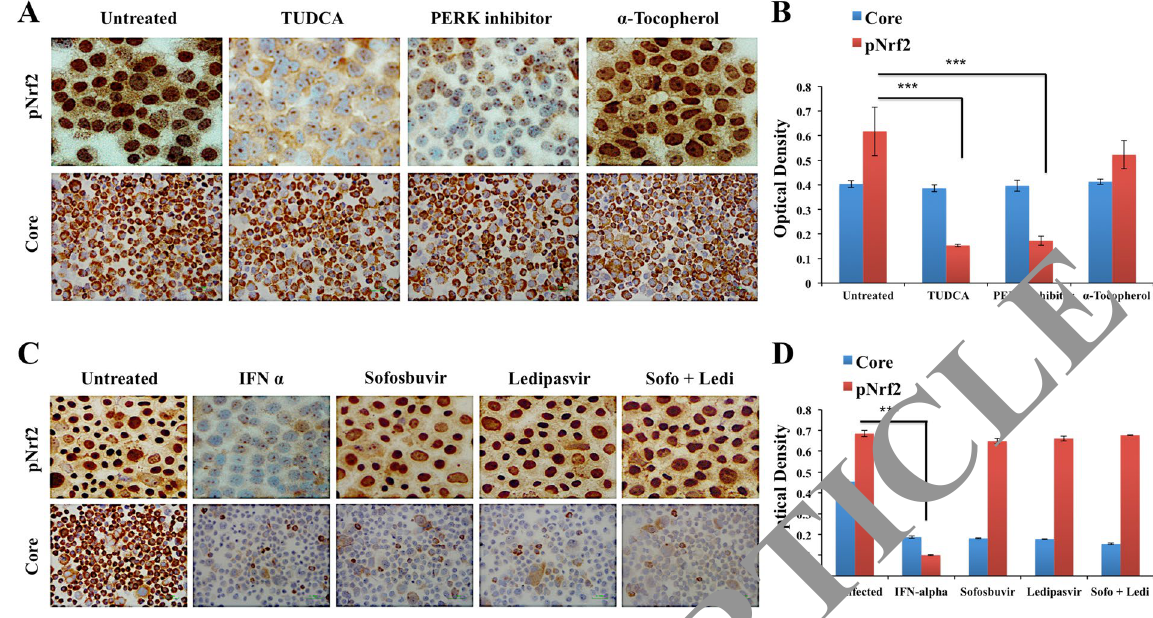
Figure 9. The effect of ER-stress inhibitors and oxidative stress inhibitors on Nrf2 nuclear translocation and HCV replication. Persistently HCV infected Huh-7.5 cells were treated with ER-stress inhibitor TUDCA, PERK inhibitor, and an anti-oxidant ( α -tocopherol) for 72 hours. After this treatment, cells were harvested by trypsin- EDTA, washed with PBS, and immobilized onto glass slide by cytospin method. Immunostaining for HCV core and pNrf2 was performed. (A) Shows the nuclear translocation of pNrf2 in HCV infected Huh-7.5 cells with different inhibitors. Short-term treatment with inhibitors did not change HCV core expression. (B) Shows the quantification core and Nrf2 nuclear translocation after different inhibitors by ImageJ software. (C) Impact of HCV clearance by DAA treatment on the Nrf2 nuclear translocation. HCV infected Huh-7.5 cells day 12 were given two rounds of antiviral treatment with IFN- α , sofosbuvir, ledipasvir or combination of sofosbuvir plus ledipasvir. After 72 hours, cells were split, and then treated again with the same antiviral agent. After two rounds of antiviral treatment, the expressions of HCV core and pNrf2 were measured by immunostaining. (D) Shows the quantification core and Nrf2 nuclear translocation after antiviral treatments by ImageJ software.